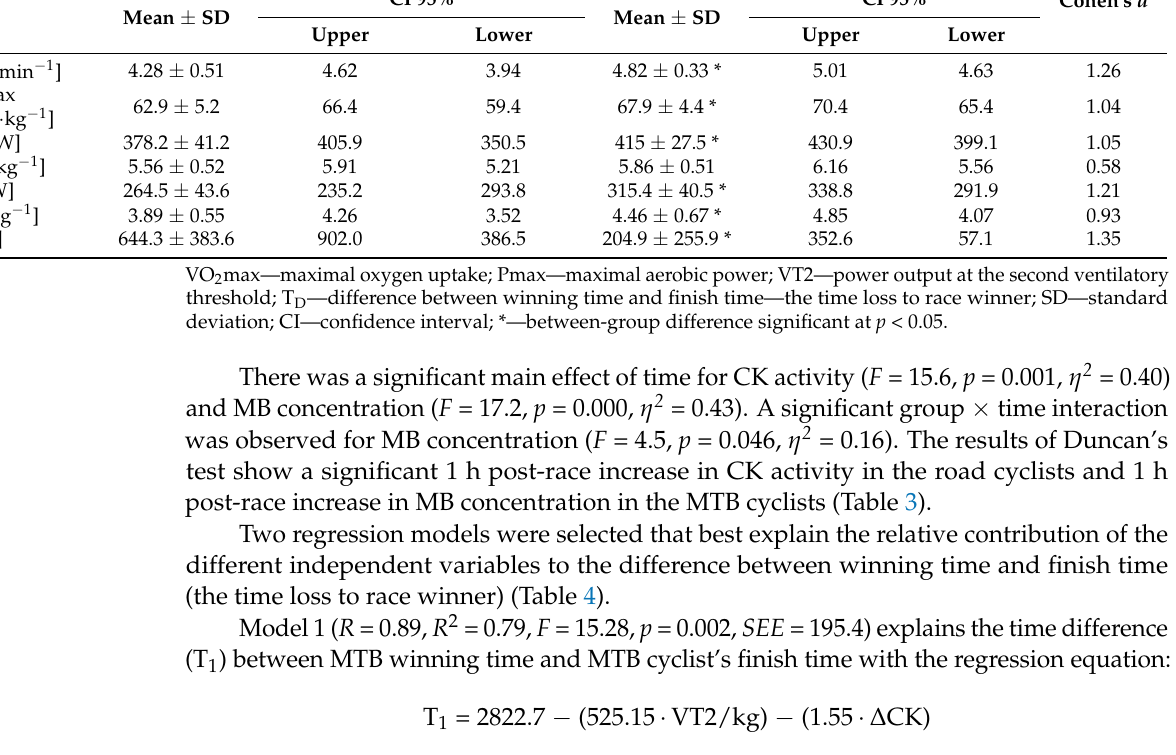
Table 2. Incremental exercise test and race characteristics of the mountain bike and road cyclists. Mountain Bike Cyclists Road Cyclists Mean ±